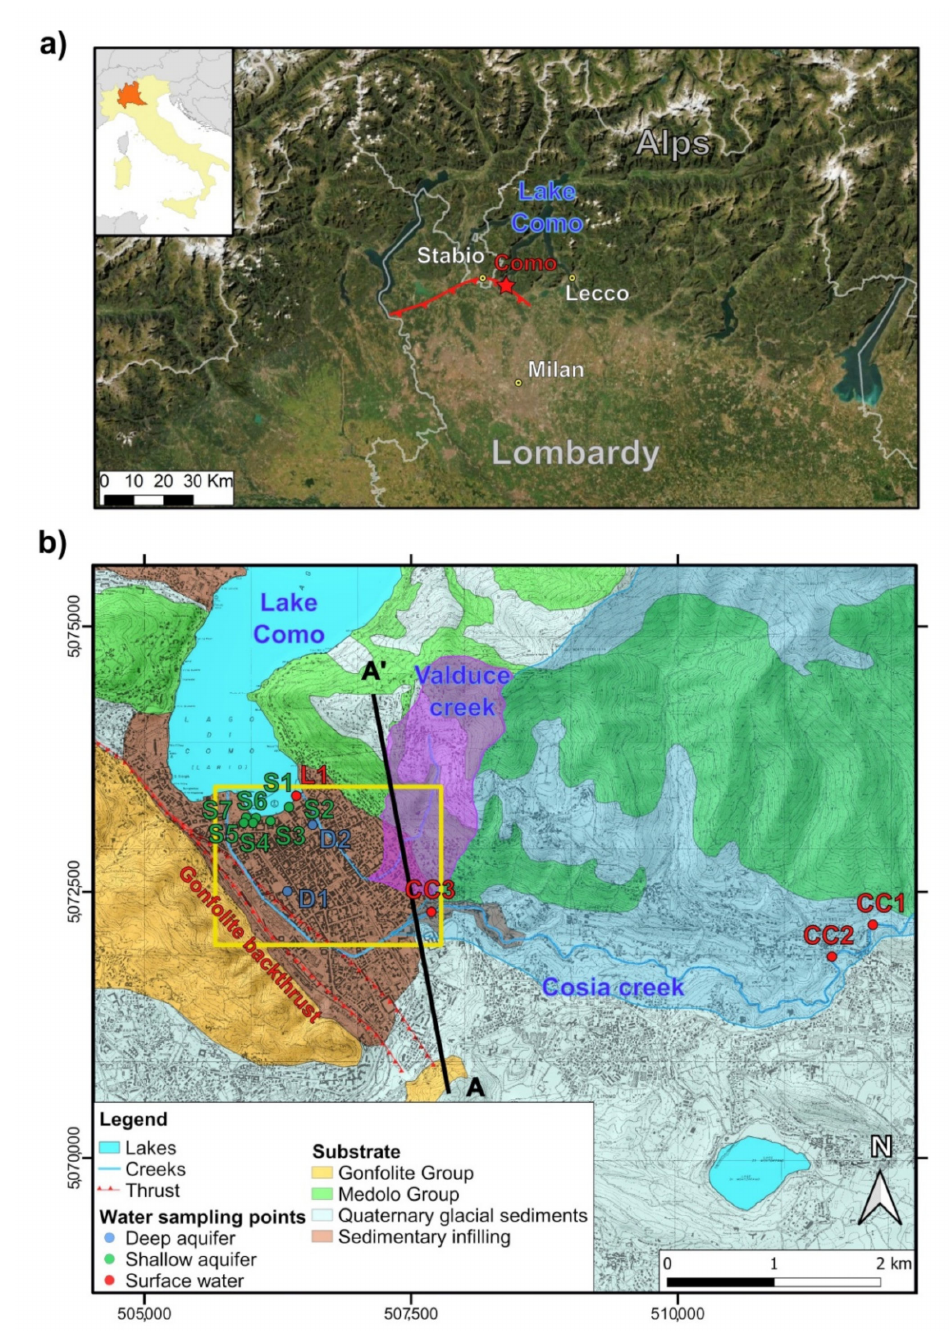
Figure 1. ( a ) Location map of the Como urban area, highlighted with a red star; Lombardy region is highlighted in orange in the upper left corner. ( b ) Simplified geologic map of the study area, modified after [14]. Water sampling points are highlighted as well, while the sediment cores are located in point S1 (for coreSI3) and in point D2 (for core SV2), respectively (see Figure 2). The drainage basins of the Valduce creek and Cosia creek are indicated by the shaded purple and light blue polygons, respectively. Moreover, the yellow frame indicates the extension of map in Figure 2a, and the black line indicate the location of section A-A’ in Figure 7. The red line in ( a , b ) indicates the trace of the Gonfolite backthrust. Topo map: CTR (Carta Tecnica Regionale), provided by Regione Lombardia